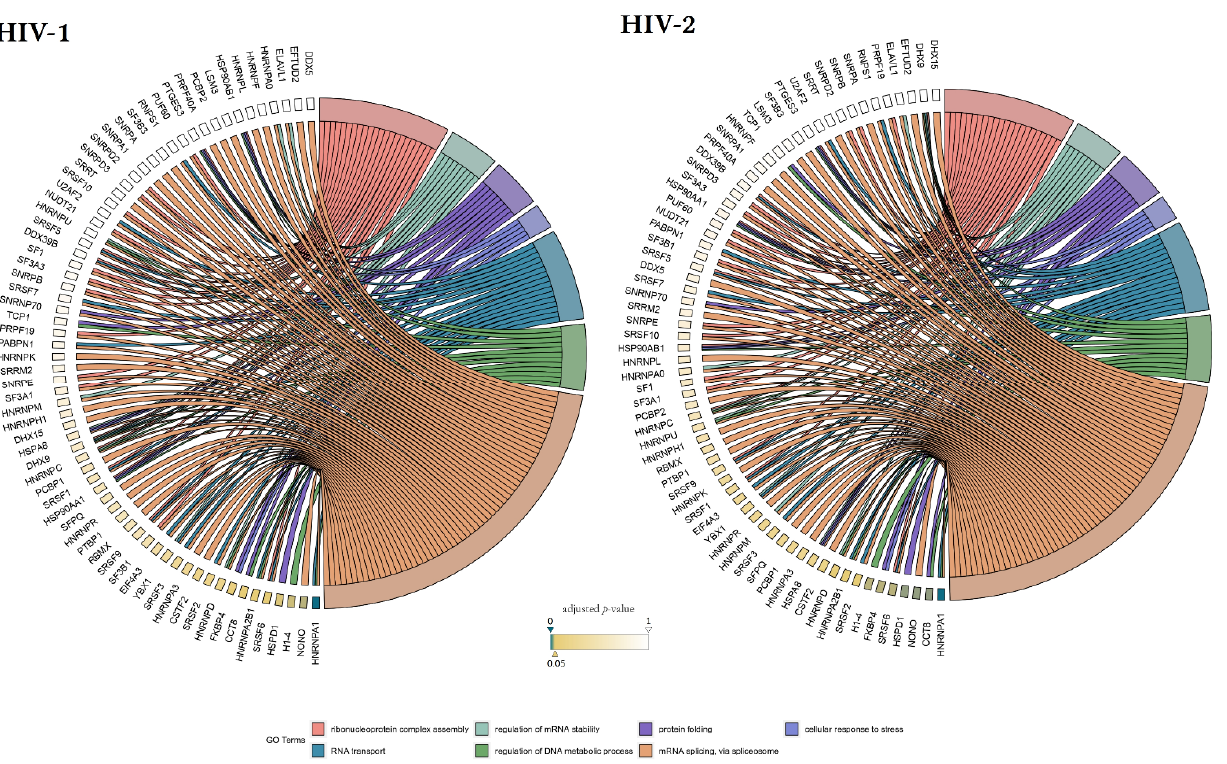
Figure 7. Protein association analysis. Associations between the 7 selected GO terms (ribonucleoprotein complex assembly— GO:0022618, RNA transport—GO:0050658, regulation of mRNA stability—GO:0043488, regulation of DNA metabolic process—GO:0051052, protein folding—GO:0006457, mRNA splicing via spliceosome—GO:0000398, and cellular response to stress—GO:0033554), and proteins from the enriched interaction network also detected by MS/MS. Colour intensities of the rectangles reflect the significance of change in the corresponding protein levels relative to control (α=0.05; color scale: p=0—marine blue, p=0.05—gold, p=1—white). The chords plots were generated with the GOplot R package [38].